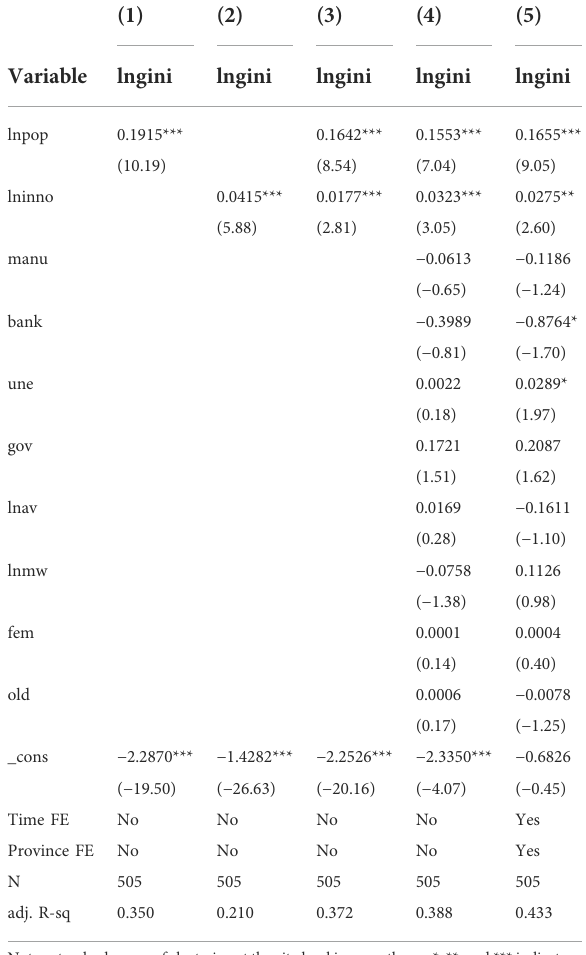
TABLE 3 Baseline regression